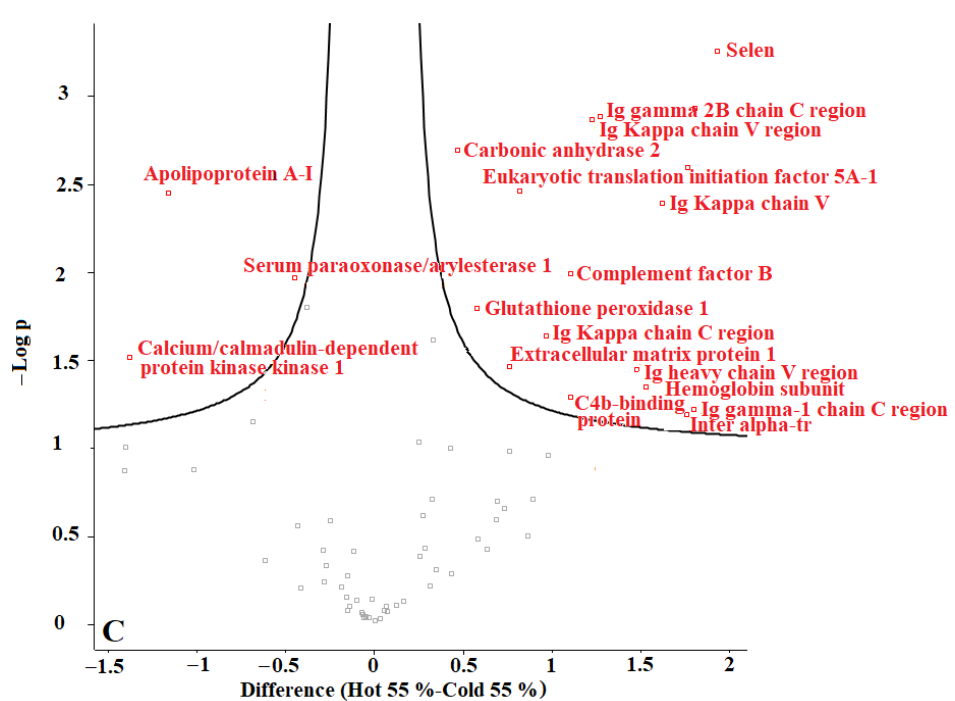
Figure 10. Volcano plots generated with Perseus software for 3 different groups of AuNPs. ( A ) dif- ferences in protein coronas of “cold” and “hot” AuNPs with 10% plasma content, ( B ) “cold” and “hot” AuNPs with 25% plasma content, and ( C ) “cold” and “hot” AuNPs with 55% plasma content. According to the horizontal axes, from 0 to the left is the “hot” protein corona, and from 0 to the right is the “cold” protein corona, showing their differences.